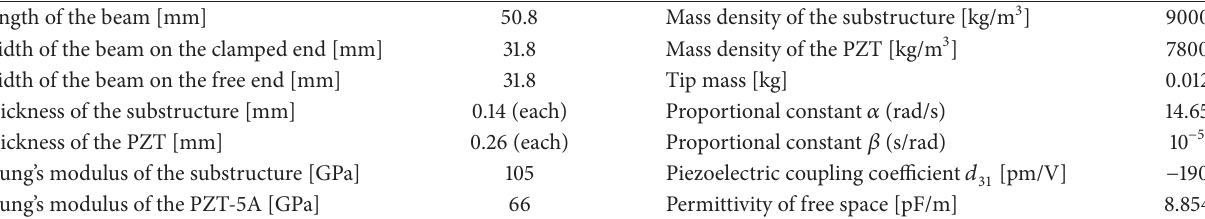
Table 1: Geometric and material properties of the bimorph